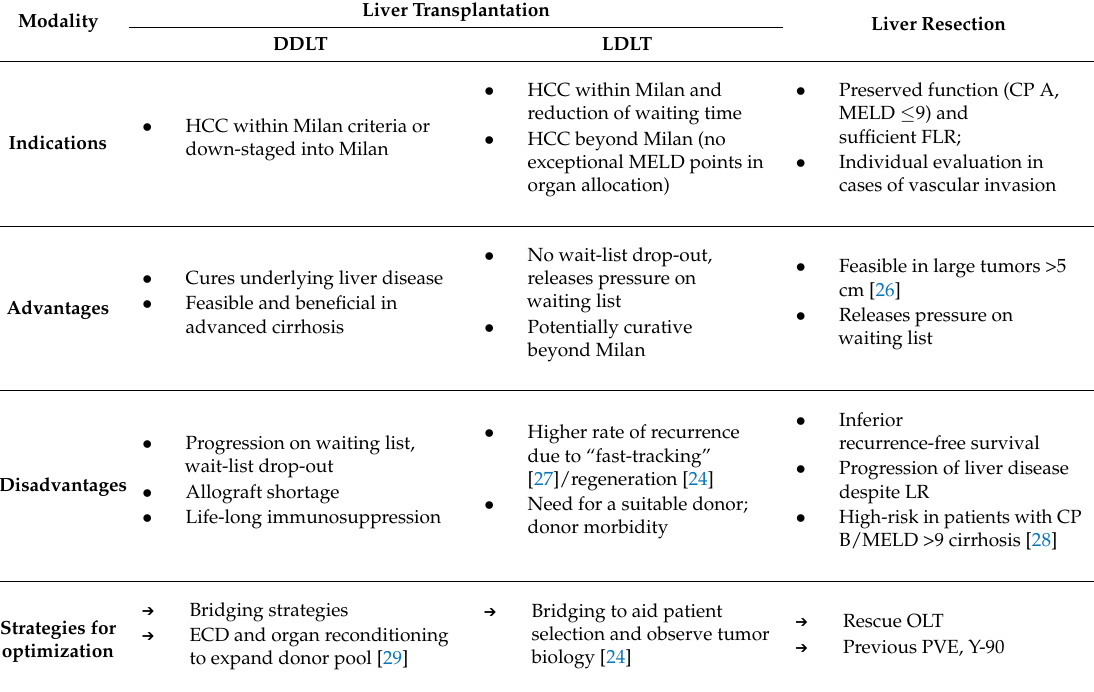
Table 1. Clinical decision-making: liver transplantation vs. resection in BCLC 0 and A (and